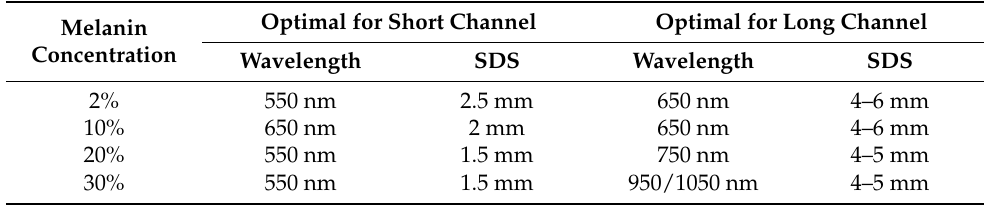
Table 2. Summary of suggested optimal NIR